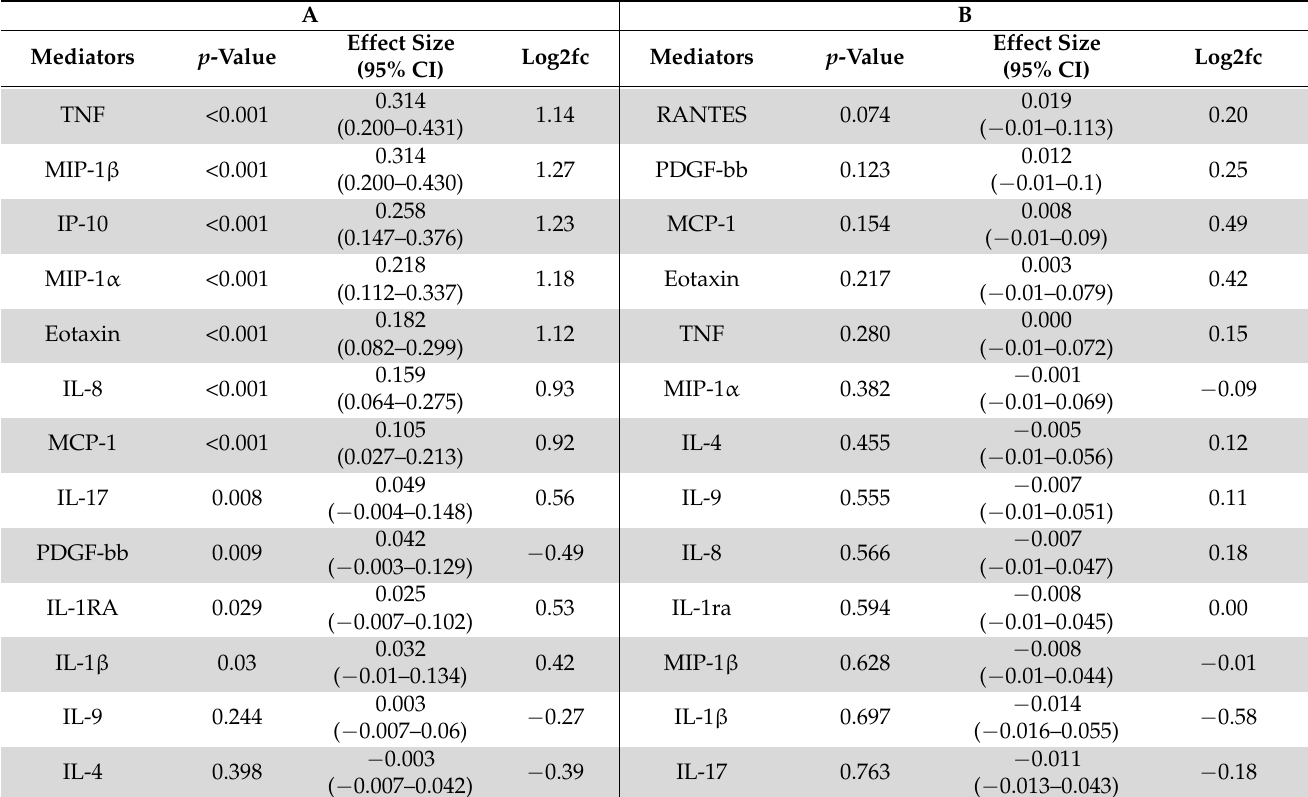
Table 2. Serum levels of mediators in patients with hand osteoarthritis and healthy controls. The difference was studied between (A) HOA patients and healthy controls and (B) patients with erosive and non-erosive HOA. ANOVA was performed for both subgroups. Data were described as p -value, effect size (computed as partial omega) with 95% CI, and fold-change (calculated as the proportion of medians followed by log2-transformation; positive values indicate upregulation in HOA patients and patients with the erosive disease, respectively). Mediators are sorted in ascending order based on p -values. A